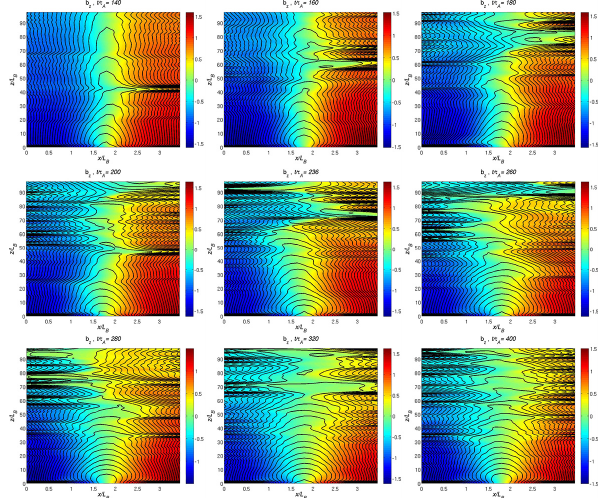
Fig. 6. Ensemble variance of the normalised z component of the magnetic field at different time steps and on the entire simulated domain. The spatial dimensions are normalised to L B , the length scale of variation of the magnetic field. Time is normalised to the Alfvén time τ A .